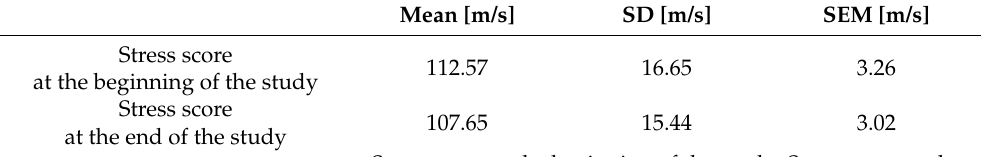
Figure 1. Evaluation of the stress level in the studied group ( a ) at the beginning and ( b ) at the end of the study (level 1, very low: ≤ 48 points; level 2, low: 49–72 points; level 3, normal: 73–120 points; level 4, high: 121–144 points; level 5, dangerously high: ≥ 145 points).